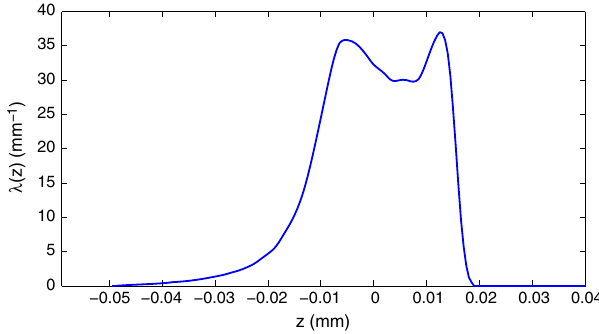
FIG. 1. The simulated form of the LCLS-II bunch at the end of the second bunch compressor. It has r.m.s. length σ and zero mean. This is a smoothed version of a histogram with 100